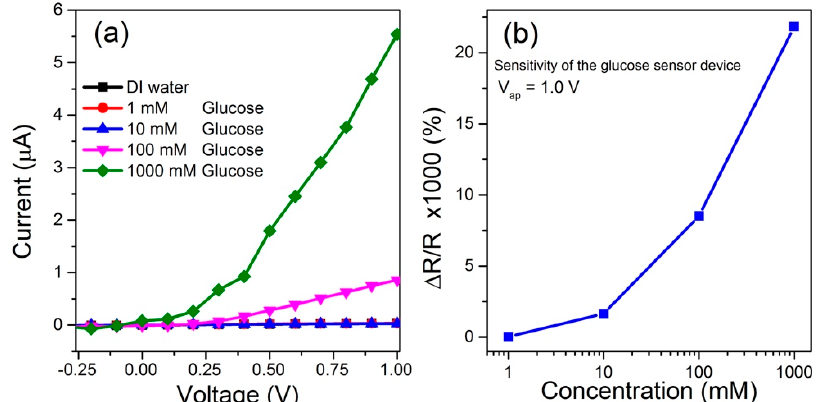
Figure 3. Experimental results concerning the biosensors electrical characterization: ( a ) current–voltage characterization for di ff erent glucose (GLU) concentrations for biosensor based on a SnO 2 nanowire; ( b ) sensitivity vs. GLU concentration for biosensor under V ap = 1.0 V.